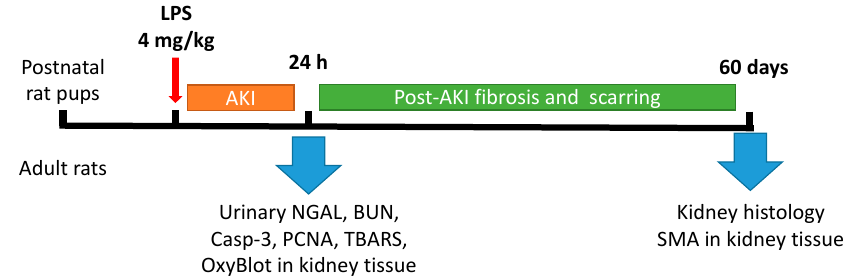
Figure 1. Design of experiments with lipopolysaccharide (LPS)-mediated acute kidney injury (AKI) in adult and newborn rats. NGAL: neutrophil gelatinase-associated lipocalin 2; BUN: blood urea nitrogen; PCNA: proliferating cell nuclear antigen; TBARS: thiobarbituric acid-reactive substances; SMA: α -smooth muscle actin.